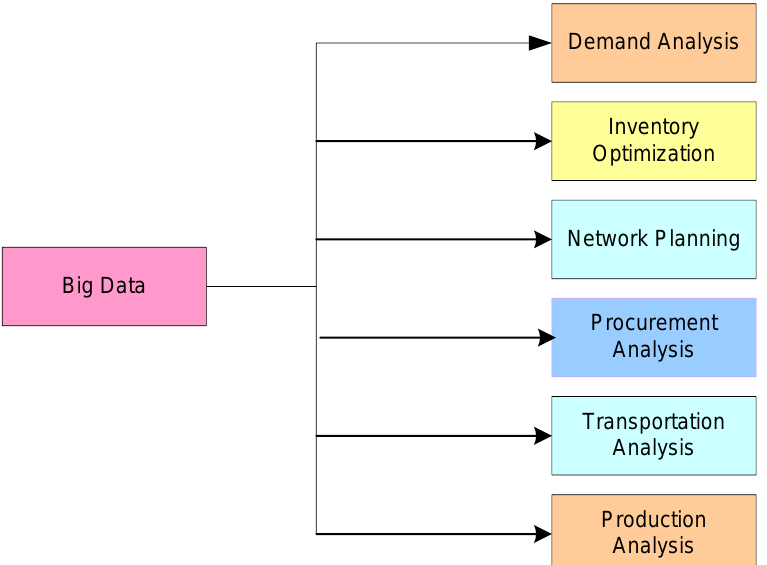
Figure 7. Application of big data in sustainable SCM. Table 2. Big data for sustainable SCM.